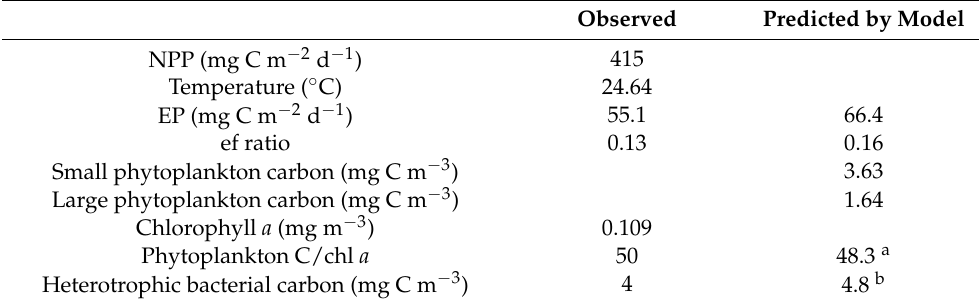
Table 2. Metrics of biomass and production observed at Station ALOHA and predicted by the food web model in the upper 75 m of the water column, with the exception of the observed phytoplankton C/chl a ratios, which are averages for the upper 45